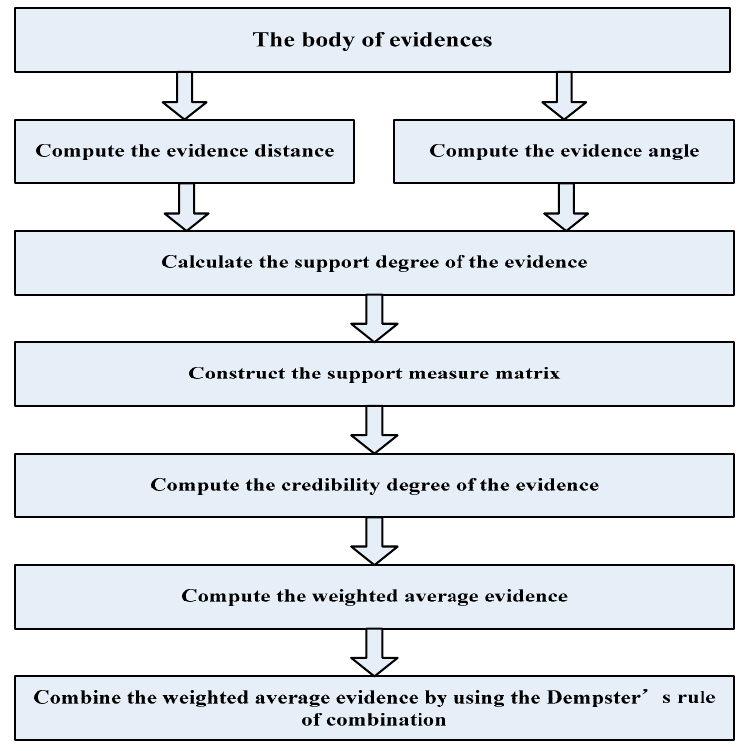
Figure 4. The flowchart of our proposed method.